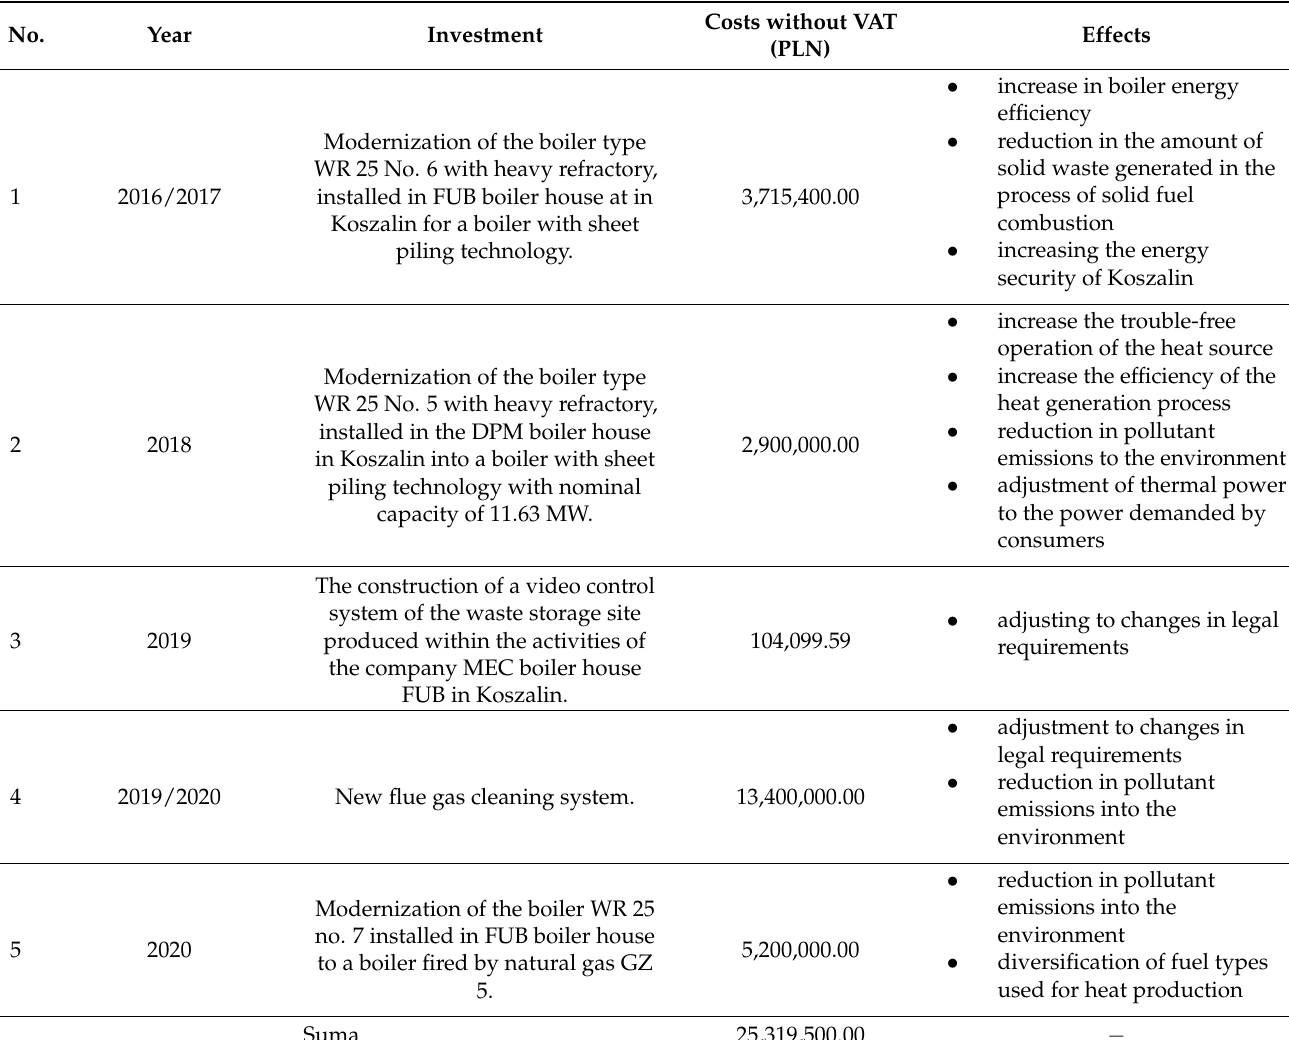
Table 1. Pro-ecological investments in MEC Koszalin—years